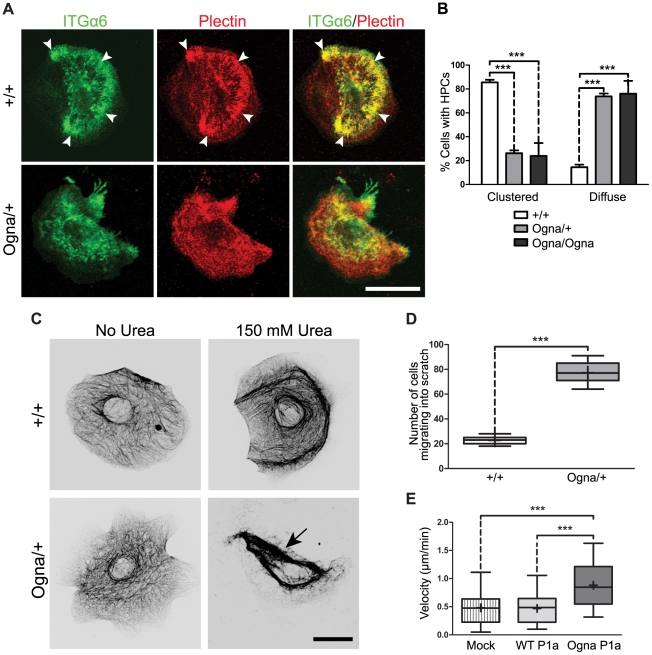
Compromised ex vivo formation and function of HPCs in Ogna keratinocytes.(A) Immunolocalization (double labeling) of ITGα6 and plectin in primary keratinocytes isolated from newborn mice. In wild-type (+/+) keratinocytes ITGα6 and plectin show codistribution in densely clustered HPCs (arrowheads) contrasting the more diffuse distribution in Ogna keratinocytes. Bar, 20 µm. (B) Column diagram showing proportions (%) of wild-type (+/+) and mutant keratinocytes having formed (clustered), or lacking (diffuse) HPCs. Data are shown as mean values from cell counts (>100/genotype) in randomly chosen optical fields from three independent experiments ±95% CI. *** P<0.001, two-way ANOVA with Bonferroni post test. (C) Immunofluorescence microscopy images (contrast–enhanced by conversion to grey scale and inversion of contrast) of keratin 5 filament networks in hyperosmotic shock-treated (+urea) and non-treated keratinocytes. Note more advanced network collapse in Plec
Ogna/+ (arrow) compared to wild-type keratinocytes. Bar, 20 µm. (D) Comparison of cell numbers re-populating scratch wounds (n = 15) 16 hours after wound infliction. Box and whisker plots as in Figure 2. *** P<0.001, unpaired two-tailed t-test. (E) Migration velocities of keratinocytes overexpressing wild-type and Ogna-P1a. Immortalized Plec
+/+ keratinocytes, transfected with either full-length wild-type (WT) P1a (n = 30 cells), or Ogna P1a (n = 34 cells), or empty (GFP-expressing) vector (mock, n = 30 cells), were monitored for migration over a period of 20 hours. Box and whisker plots as in Figure 2). *** P<0.001, one-way ANOVA with Tukey post test for multiple comparisons.